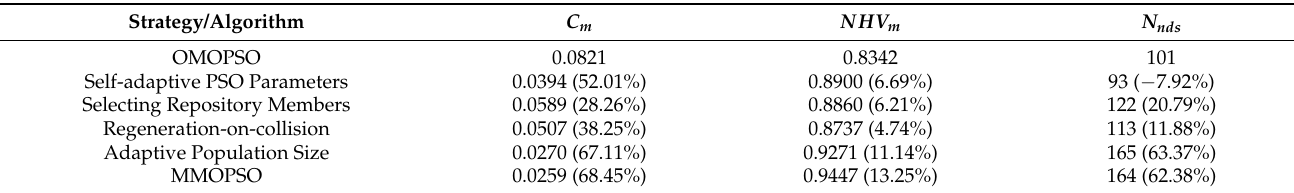
Table 2. Average values of C m , NHV m , and N nds for each strategy/algorithm (relative improvements with respect to OMOPSO are in